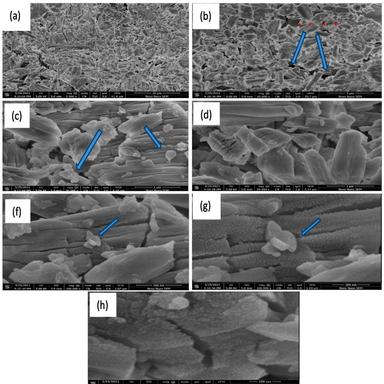
Scanning electron microscope (SEM) images of composite samples. (Legend: (a) No buffing dust content; (b) 5% (w/w) buffing dust; (c) 10% (w/w) buffing dust; (d) 15% (w/w) buffing dust; (e) 20% (w/w) buffing dust, (f) 25% (w/w) buffing dust; (g) 30% (w/w) buffing dust.